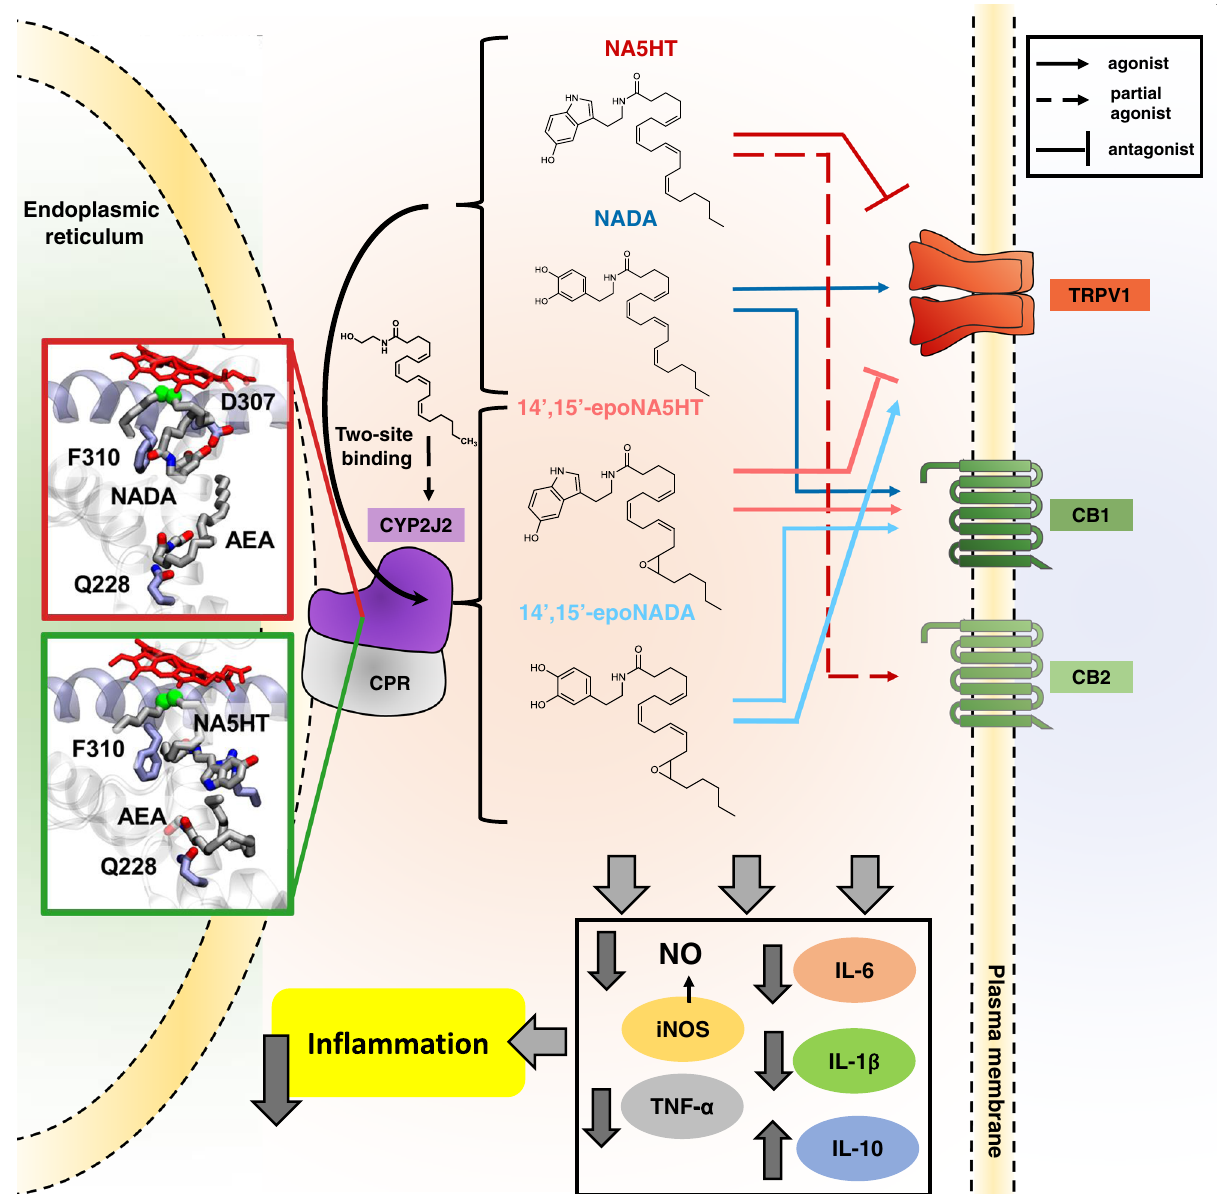
Fig. 7 Summary of the eVD metabolism pathway and pharmacology. The eVDs bind in a two-site model to CYP2J2 and other epoxygenases and are metabolized to form epoxy-eVDs. AEA potentiates the metabolism of eVDs as revealed by BV2 metabolism assays, in vitro CYP2J2 kinetics, and molecular dynamics simulations. 14 ’ ,15 ’ -epoNADA is a better TRPV1 agonist and slightly weaker CB1 agonist compared to NADA. 14 ’ ,15 ’ -epoNA5HT is a better TRPV1 antagonist compared to NA5HT, and is a CB1 full agonists as opposed to NA5HT, which is a partial CB2 agonist. Overall, the eVDs and epoxy-eVDs potently downregulate pro-in fl ammatory NO production and Il-6 , Il-1ß , and Tnf- α expression while increasing Il-10 expression, thereby demonstrating that they are potently anti-in fl